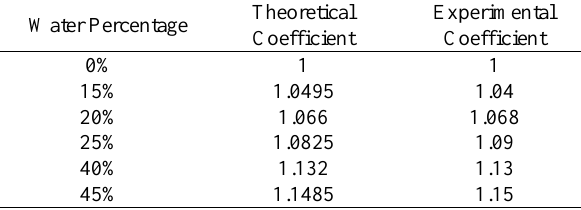
Table 3. resulting coefficients regarding to the intervening water percentages up to